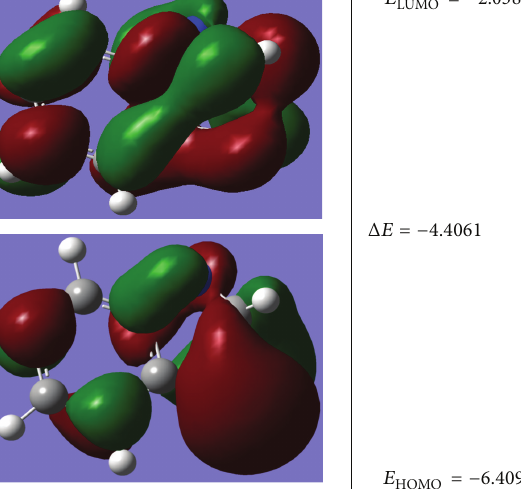
Figure 6: The molecular orbitals and energies for the HOMO and LUMO of the title compound.